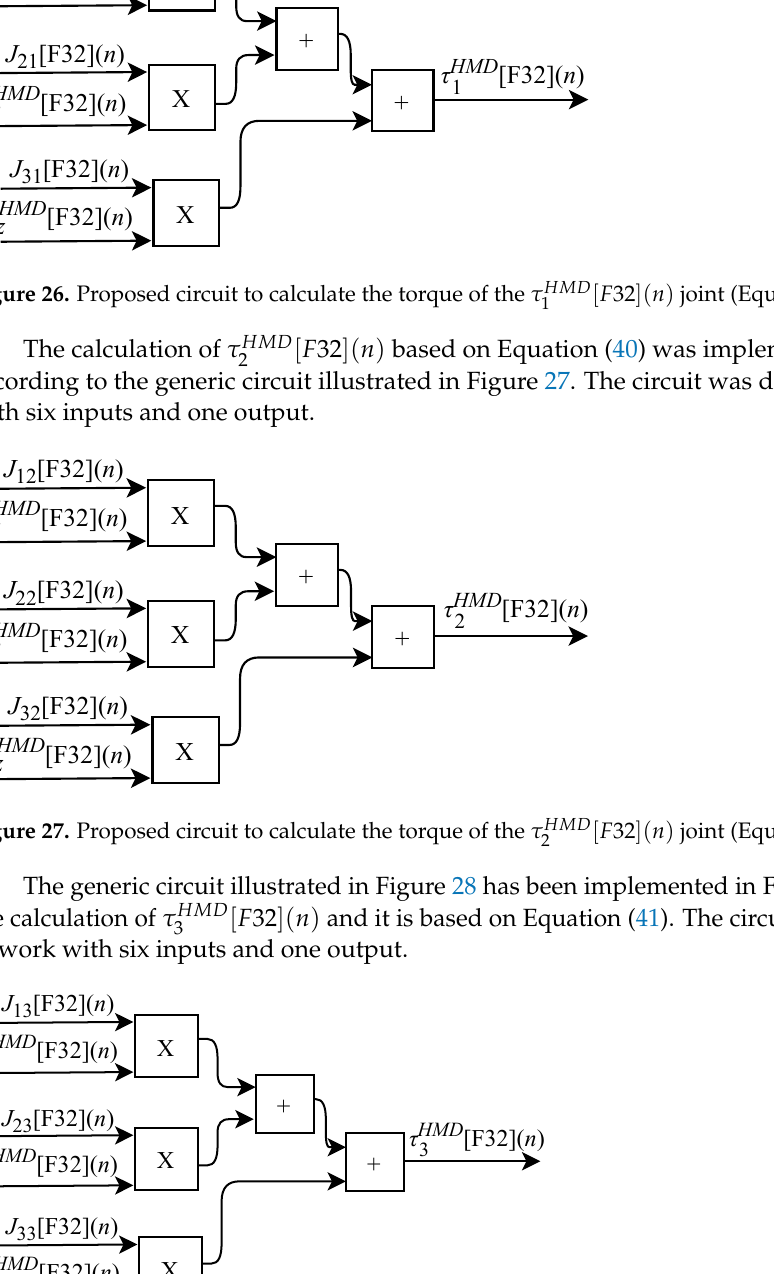
Figure 28. Proposed circuit to calculate the torque of the τ HMD